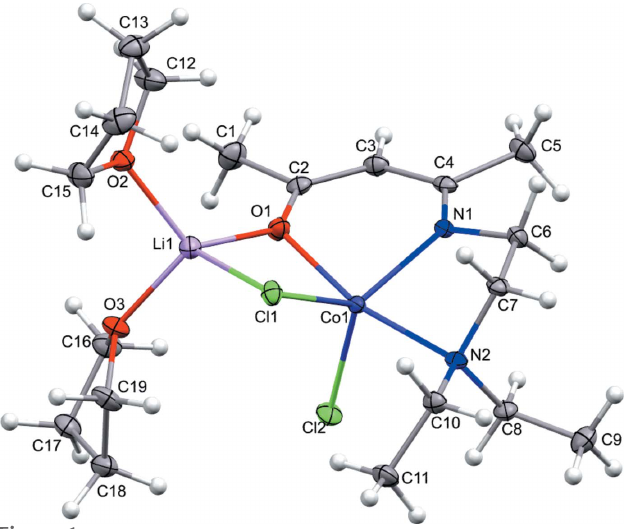
Figure 2 Packing of the molecules viewed along the b- axis direction. C—H (cid:2)(cid:2)(cid:2) Cl hydrogen-bonding interactions are shown as red dashed lines.